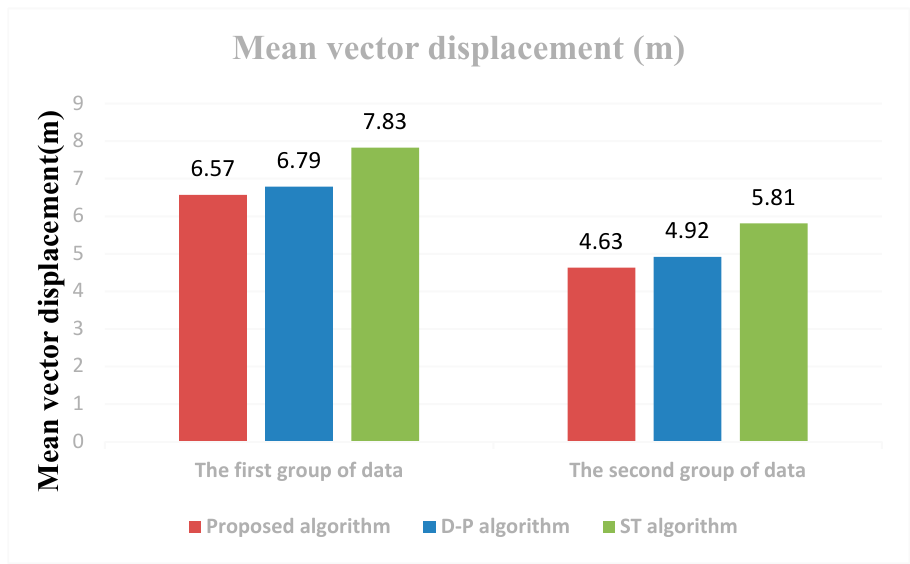
Figure 6. The mean vector displacement results (m).